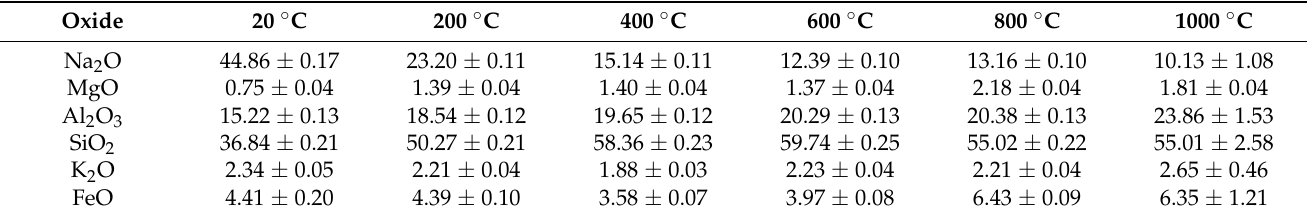
Table 4. Comparison of the oxide composition of samples Al-1 based on EDS measurements from the surface presented in SEM